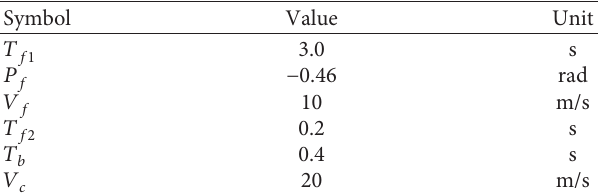
Table 2: Parameters for mode transition.